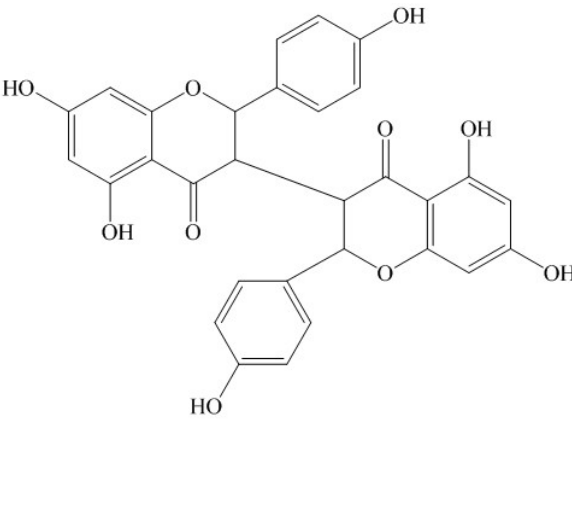
Figure 1. Chemical structure of